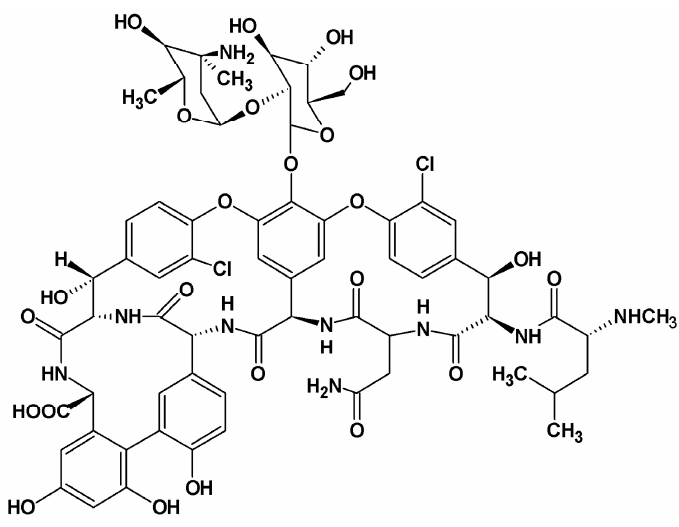
Figure 1. The chemical structure of VAN.